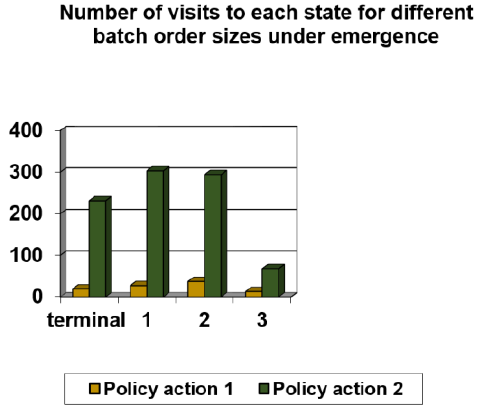
Figure 14. The number of agent visits to each state for the scheduling of one batch of 28 orders and four emergency orders, with mean order size four line items per order. The agent followed an ε-greedy policy with ε = 0.2.